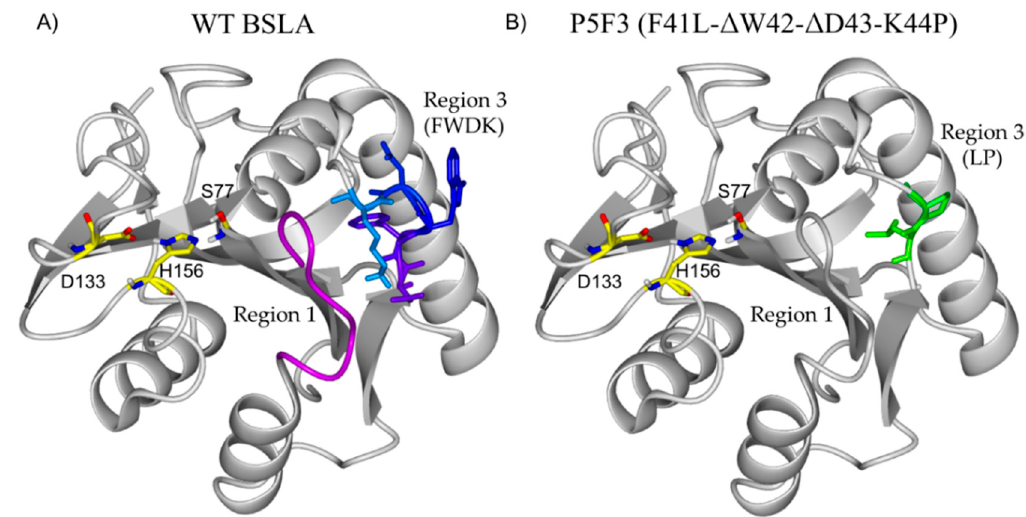
Figure 6. Structural comparison of BSLA ( A ) and the homology model of P5F3 ( B ). Interestingly, region 3 (aa positions 40 to 46) is not in the immediate vicinity of the active site of the enzyme (S77, D133 H156). In fact, region 1 (aa positions 10 to 18, pink) is located closer and between region 3 and the active site. The deleted and substituted amino acids from the original BSLA sequence are FWDR, representing two bulky aromatic residues, a negative and a positive charge residue, with potential functionality and pH response which are replaced by LP in variant P5F3.